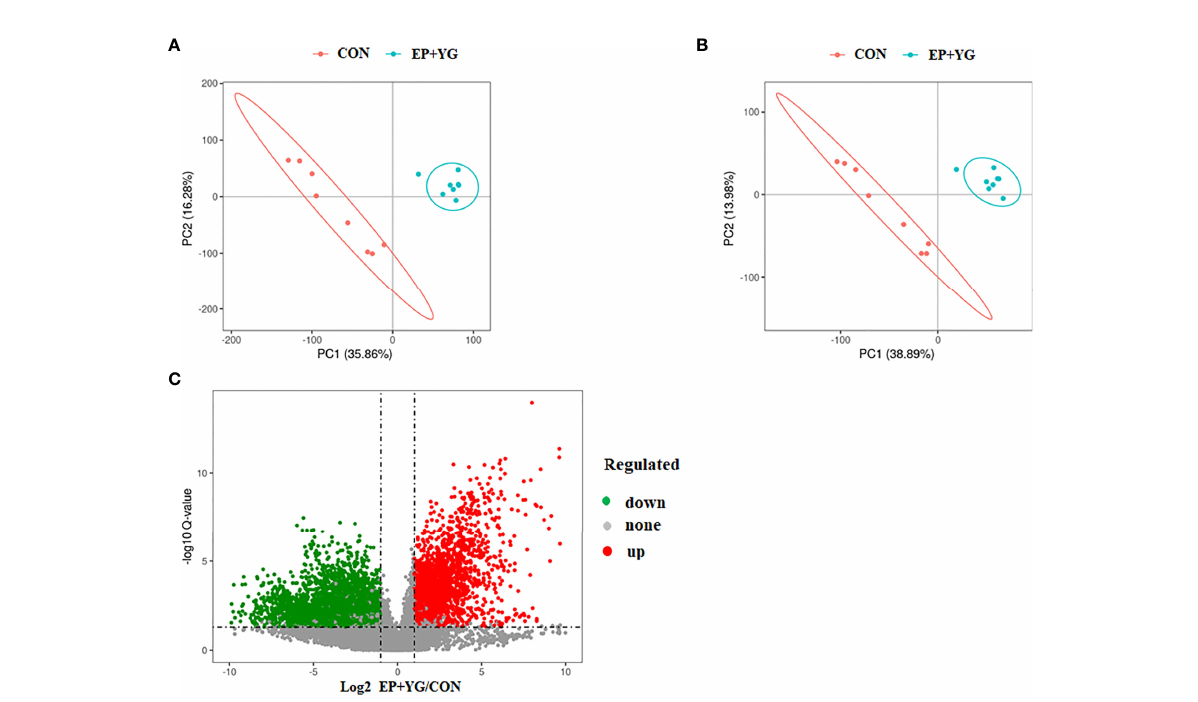
FIGURE 10 Partial least squares discriminate analysis (PLS-DA) and volcano plot of caecal metabolites in the treatment and control and chickens. The PLS- DA of microbial metabolites in caecal contents (A) positive and (B) negative ionization mode. (C) The volcano plot shows the differential metabolites between treatment groups (red dot: signi fi cantly up-regulated metabolites, green dot: signi fi cantly down-regulated metabolites, gray dot: the metabolites with no signi fi cant difference, Q < 0.05). CON (fed basal diet); EP+YG (supplemented with 200 mg EP and 200 mg YG/kg diet in combination).